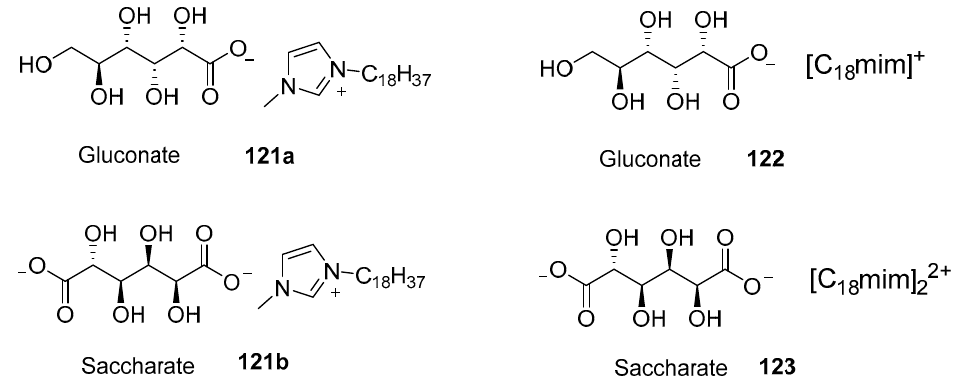
Figure 74. Carbohydrate salt-based derivatives